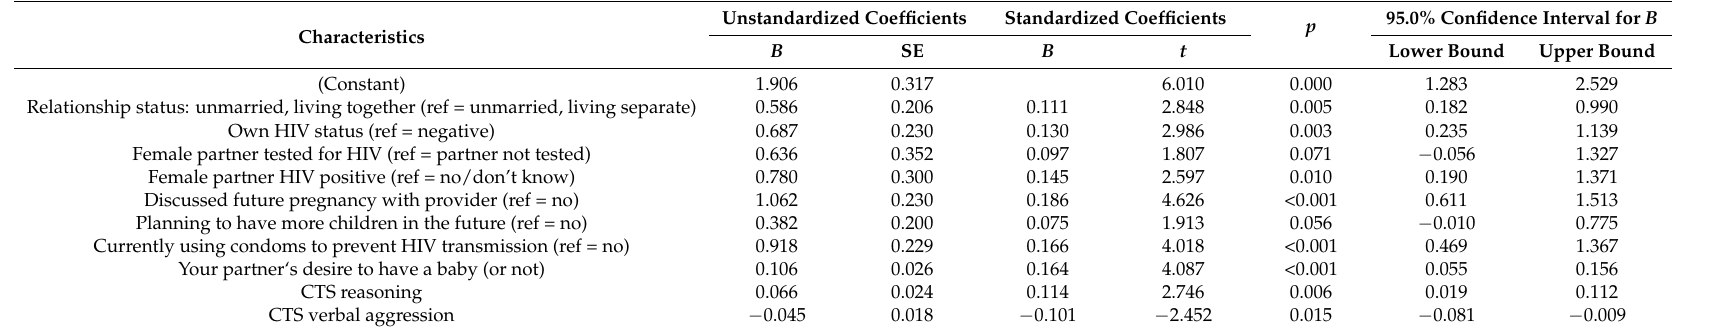
Table 4. Results of reduced multiple linear-regression model predicting MPI ( N =